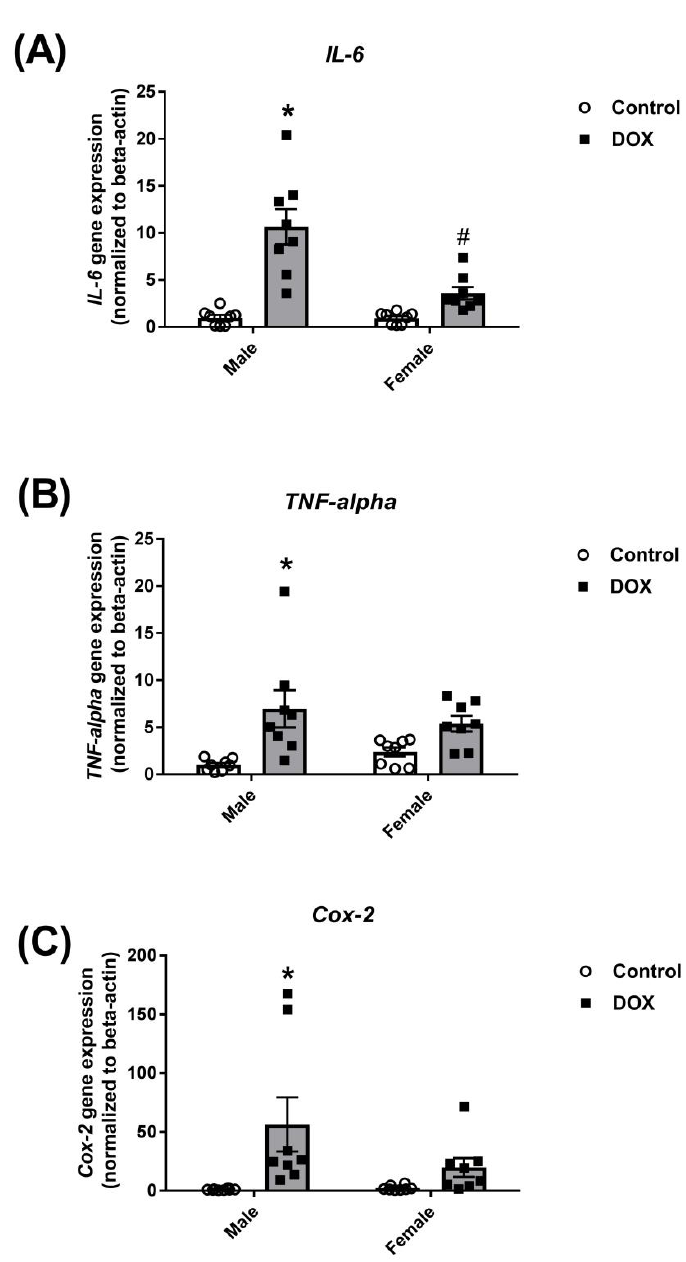
Figure 2. E ff ect of DOX treatment on the gene expression of inflammatory markers in the liver. Livers were collected from male or female C57Bl / 6 mice 24 h following the administration of a single intraperitoneal injection of 20 mg / kg DOX or saline, and total RNA was isolated ( n = 8 per group). Gene expression of ( A ) IL-6 , ( B ) TNF-alpha , or ( C ) Cox-2 was determined by real-time PCR. Results were normalized to beta-actin and are expressed relative to the male control. Data are presented as the mean ± SEM. * p < 0.05, compared to control mice of the same sex; # p < 0.05, compared to male DOX-treated mice.